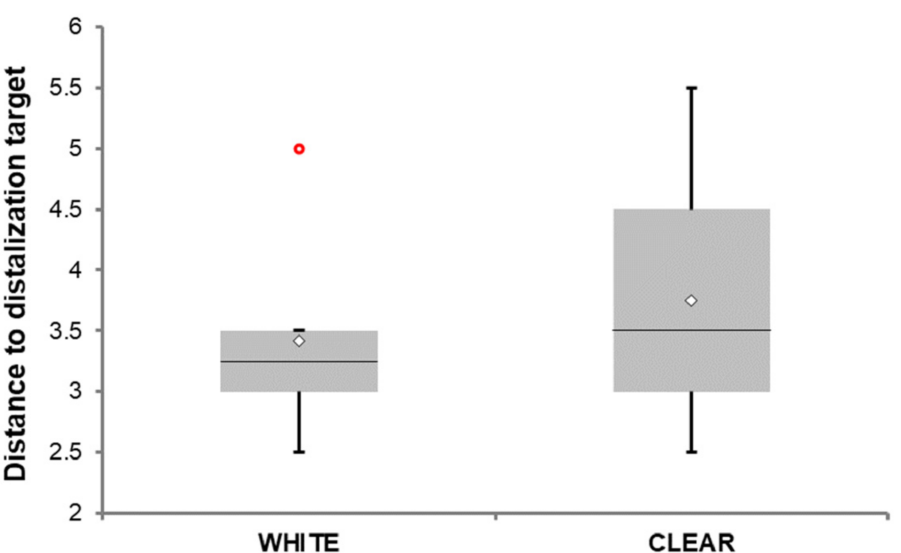
Figure 17. Data distribution of distance to distalization target stratified by type of photopolymer. Data are presented as the median (horizontal line) and mean (diamond sign), the lower-upper quartile range, minimal and maximal values. The red circle denotes an observation with a large but legitimate value that fell outside of the presumed normal distribution. A two-sample t-test verified by its non-parametric alternative was used to test the between-group differences in the distance. The difference between group means was not statistically significant ( p = 0.578). Finally, tertiary objective was to examine patients’ preference after they had completed treatment with either white or clear (transparent) material. Only two patients out of a total of 12 patients (16.7%) preferred white resin over the transparent one. The question was “Which of these two materials would you consider more aesthetically appeasing for a distalizer if you can choose?”. They were shown examples of both materials